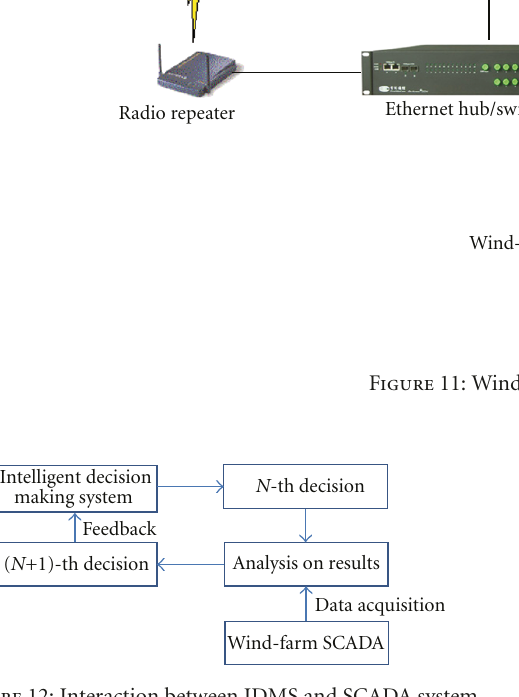
Figure 12: Interaction between IDMS and SCADA system.